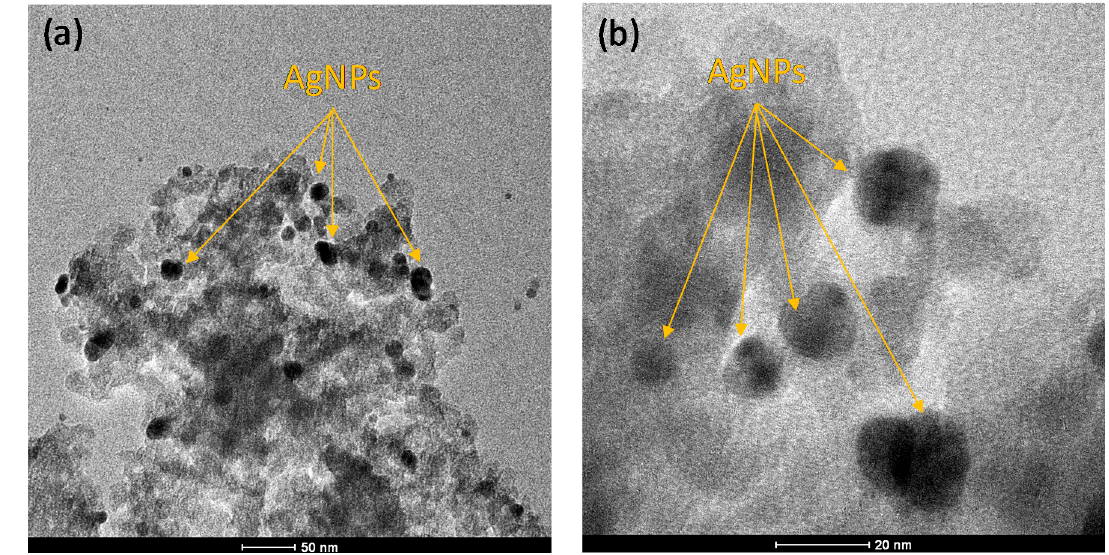
Figure 2. TEM images of Ag-loaded ZnO nanoparticles at different magnifications: ( a ) 43,000× and ( b ) 195,000×.